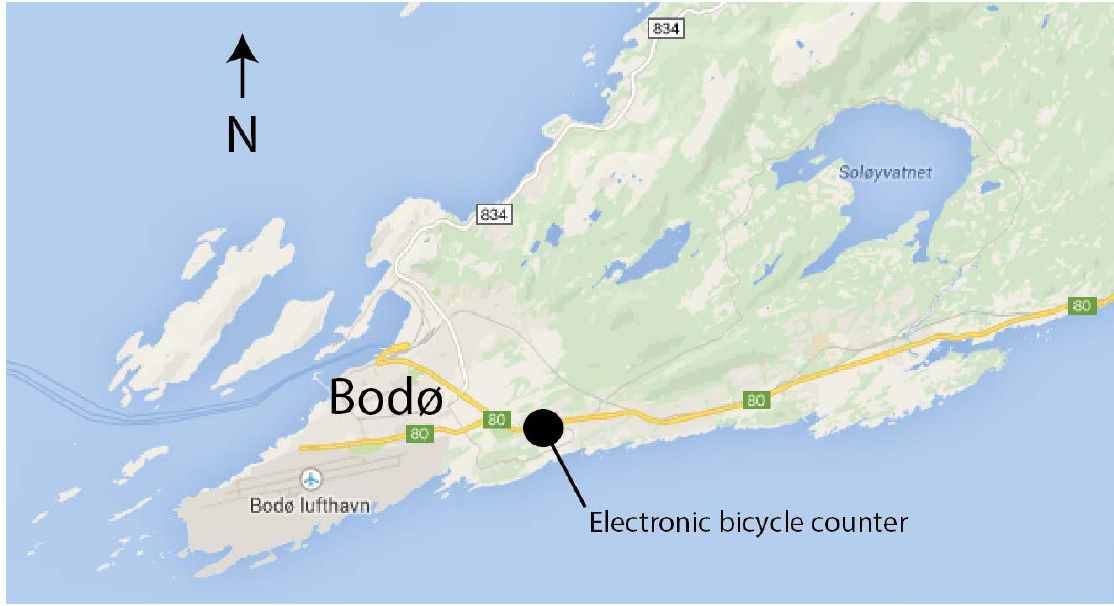
Figure 1. Location of the electronic bicycle